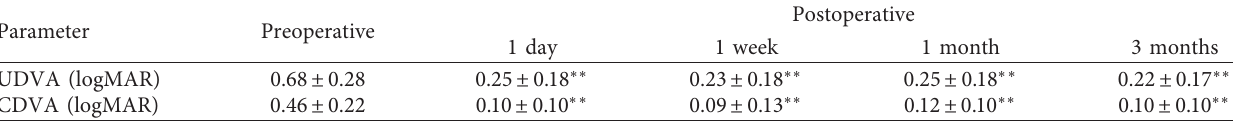
Table 2: Preoperative and postoperative visual acuity.